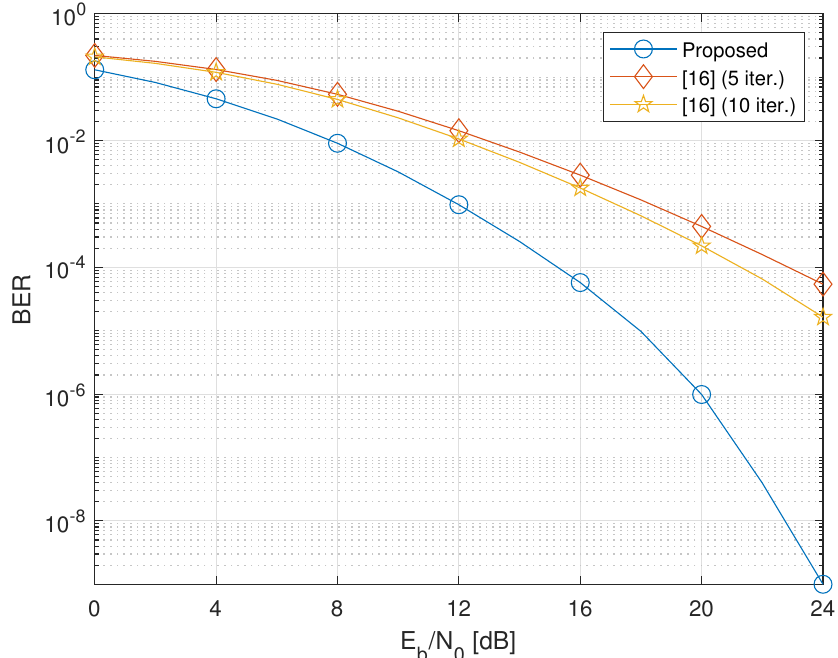
Figure 4. BER versus E b / N 0 of the proposed design versus the iterative method of Reference [16] ( N C =